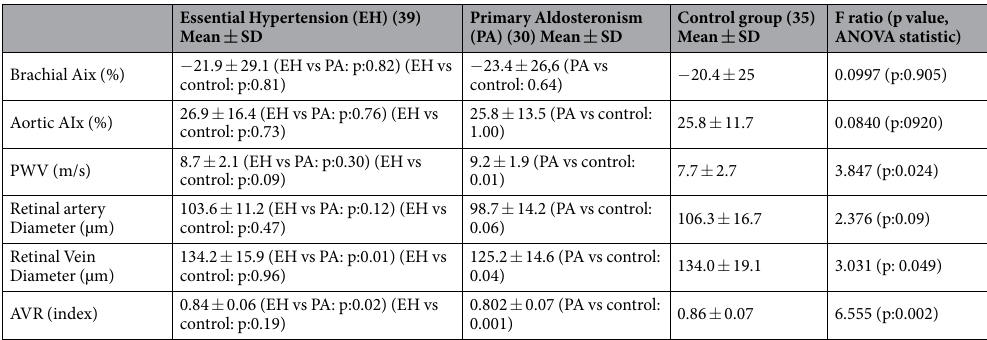
Table 2. Retinal microvascular and systemic macrovascular assessment in hypertension secondary to primary aldosteronism. Arterial stiffness parameters and retinal microvascular characteristics. Brachial AIx: Brachial